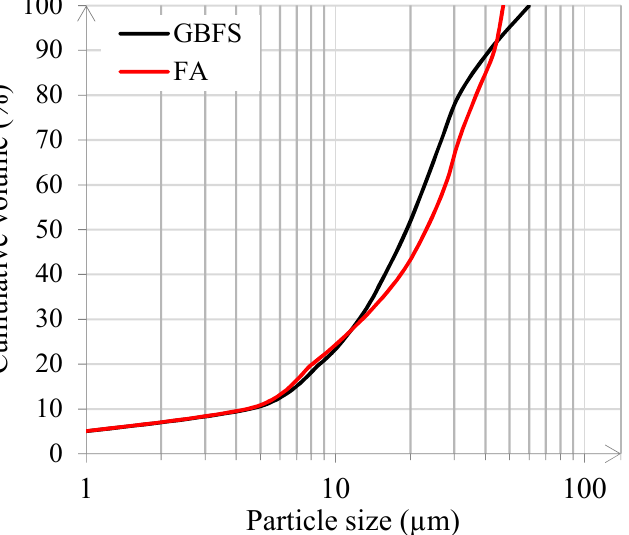
Figure 2. Particle size distributions of the studied GBFS and FA measured with Laser diffraction analyser.